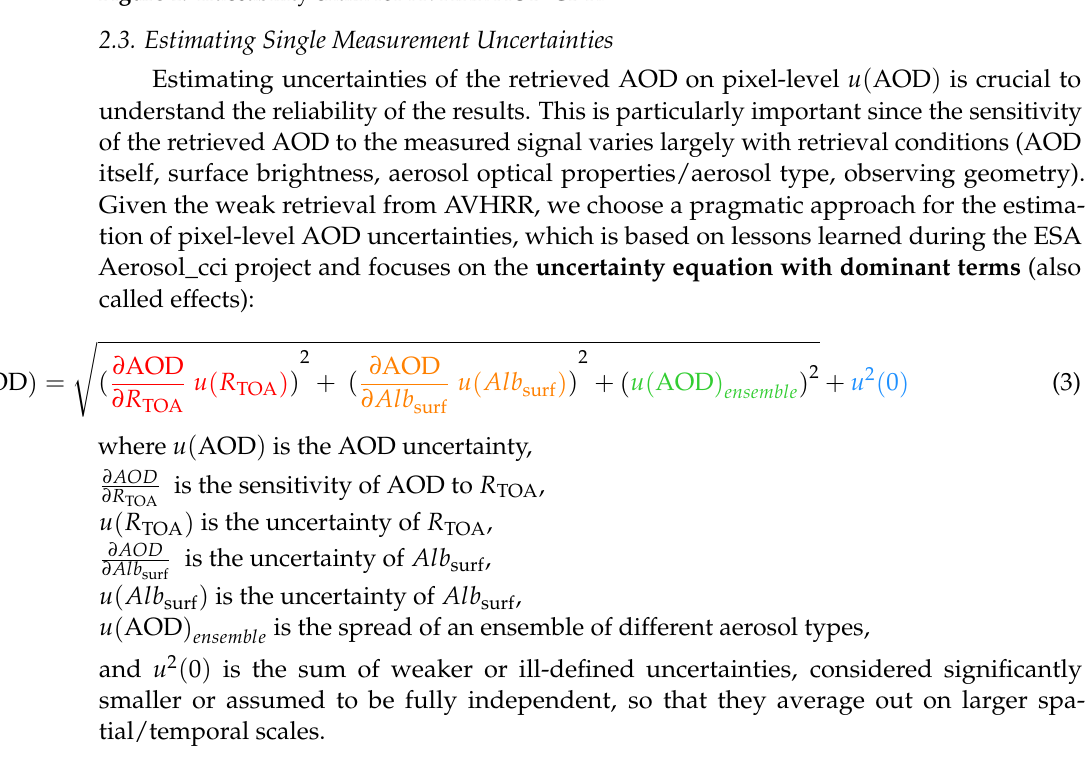
Figure 1. Traceability chain for AVHRR AOD CDR.